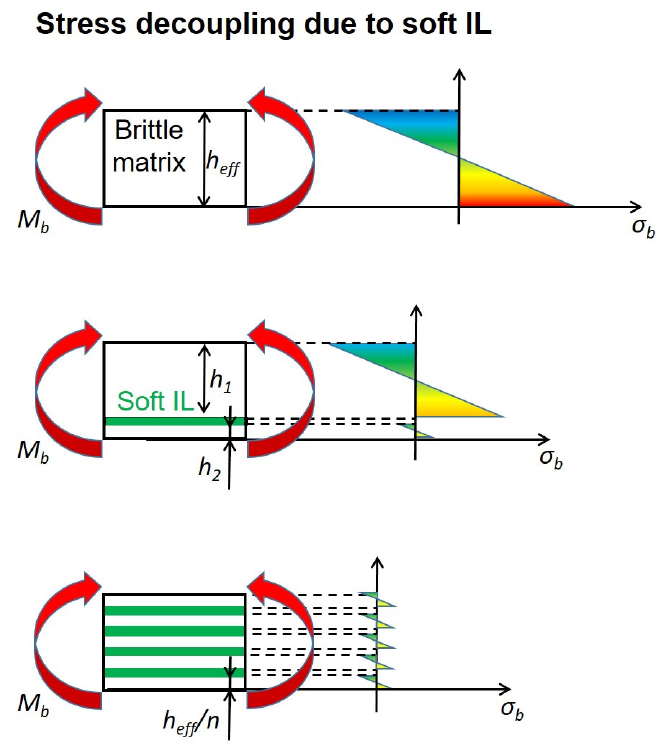
Figure 7. Decoupling of bending stresses due to soft and compliant interlayers in a stiff and brittle matrix. Stress maxima and area moment of inertia decrease as an increasing number of layers are added.